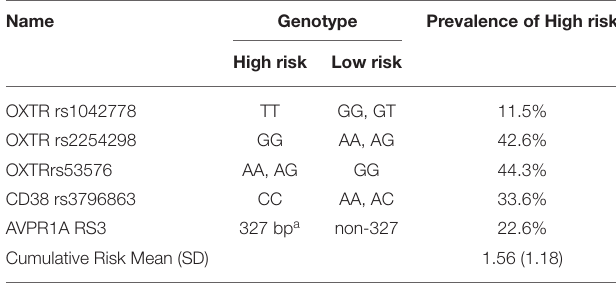
TABLE 1 | Demographic details. TABLE 2 | Genotypes on the OXTR, CD38, and AVPR1a genes in the genetic risk